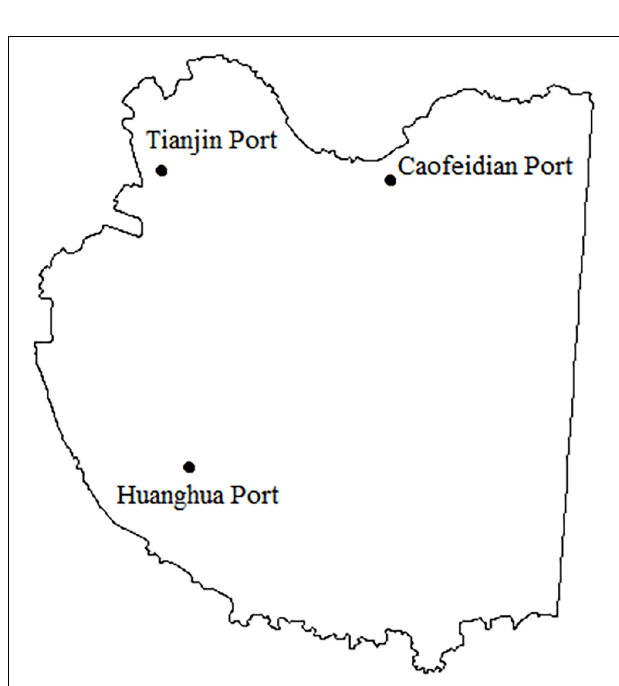
FIGURE 6 | Sketch diagram of Lagrangian particle release position.